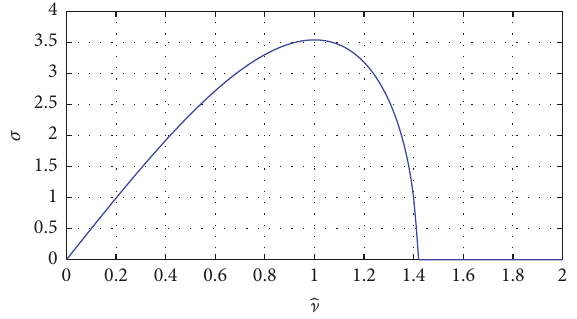
Figure 2: Graph of instability growth